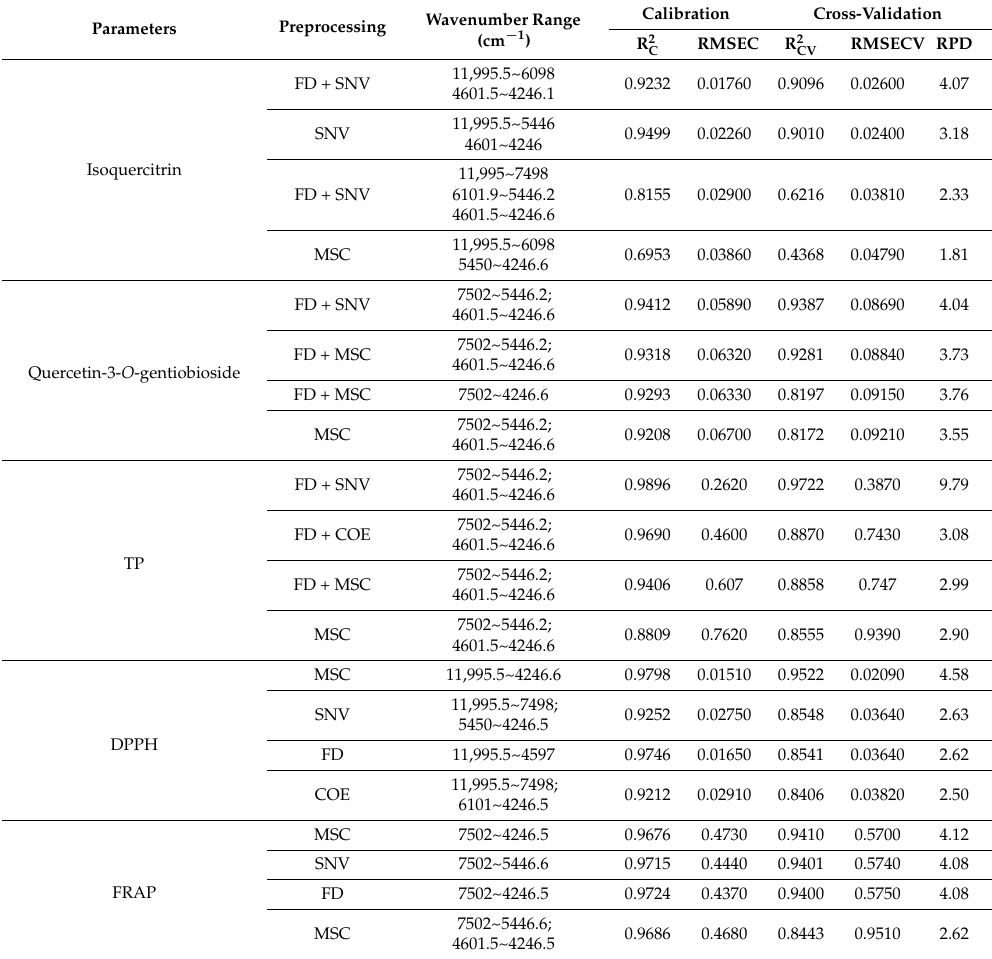
Table 2. Prediction results of antioxidants and antioxidant activity of okra seed samples by PLS with different reprocessing methods in calibration and prediction analysis.